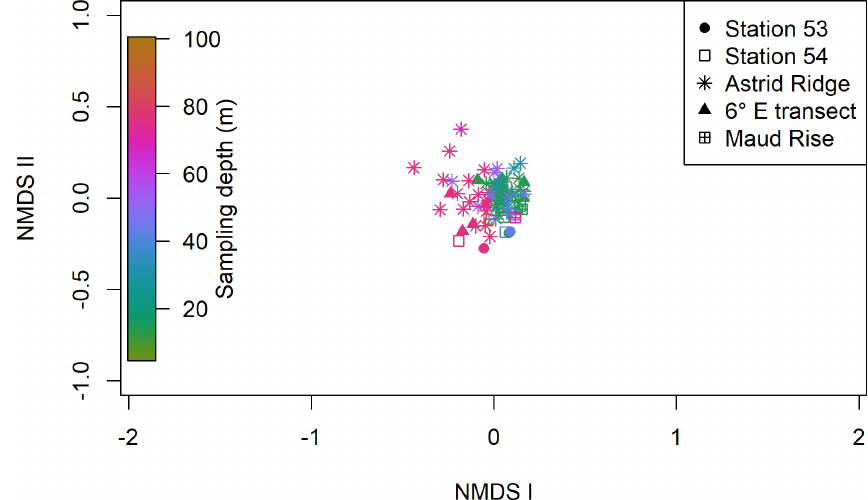
Figure A9. NMDS clustering using presence–absence